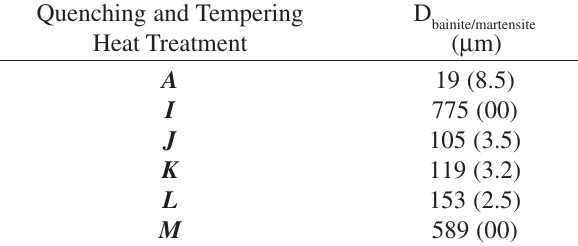
Table I. Grain diameters for the A508 steel in its original, A , and Q&T conditions, I - M . The ASTM micrograin size is provided in